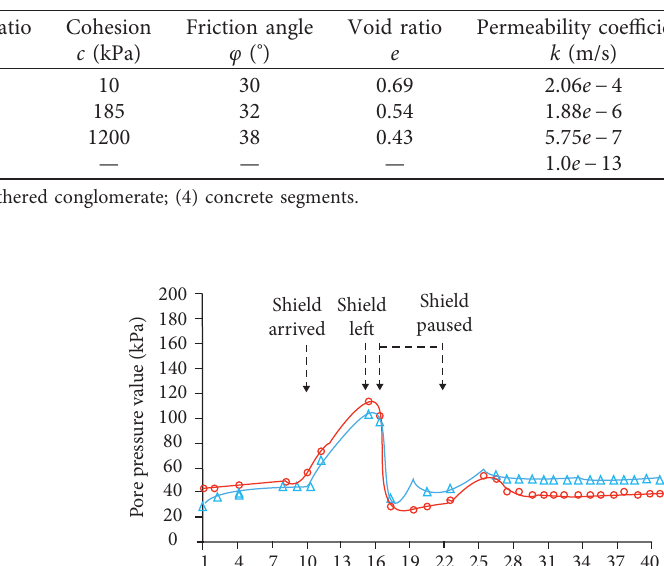
Table 1: Parameters of the finite element model.